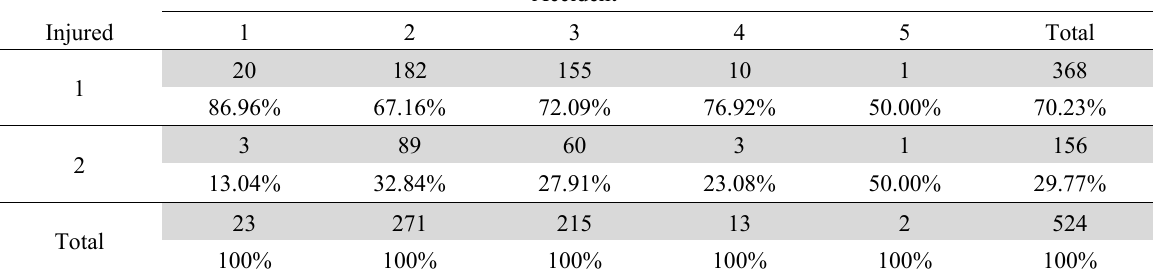
Injured quantities by accident type